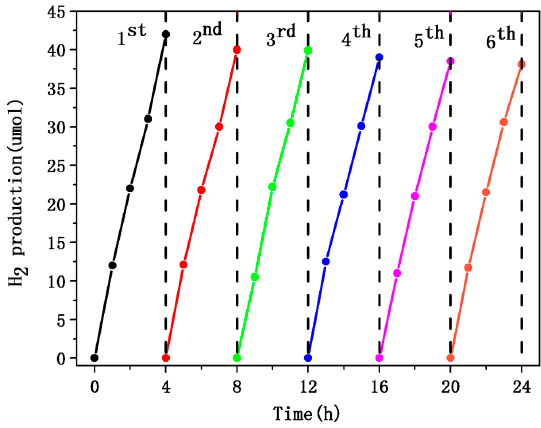
Figure 11. Recycling test of as ‐ prepared 19.2% Cu/FTO (Sn/F = 10/5) under visible light irradiation for H 2 evolution (irradiation time = 24 h).